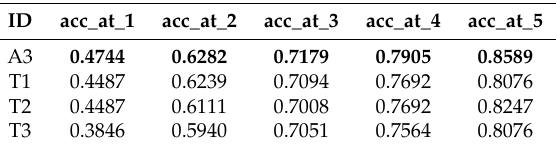
Table 5. Time experiments: Accuracy for different number of predictions. The A3 experiment depicted in the first row did not use any time information.